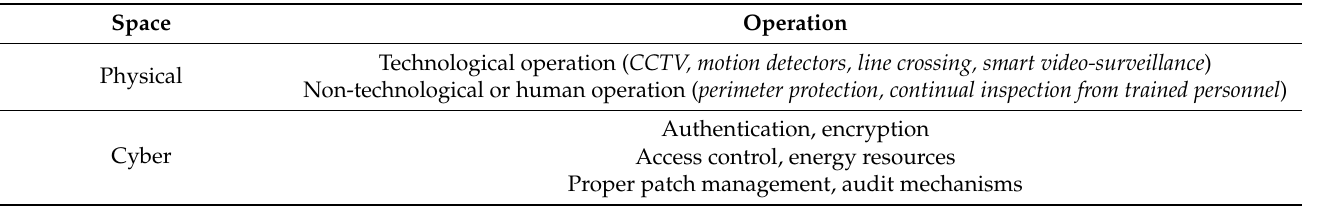
Table 3. Operation of control barriers in physical and cyber